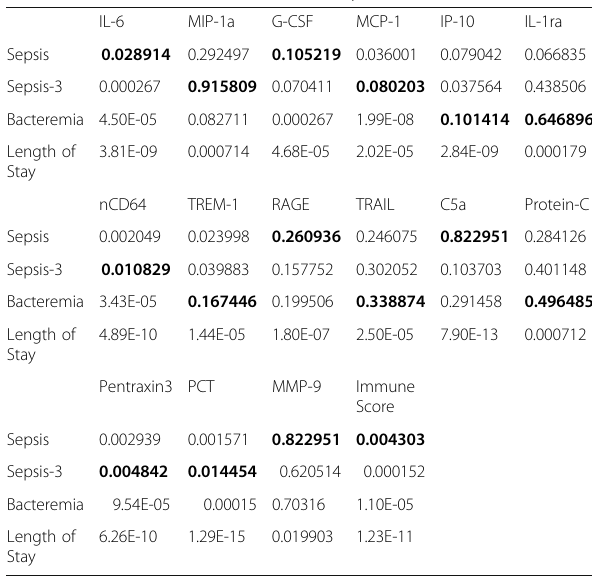
Table 3 (abstract P42). See text for